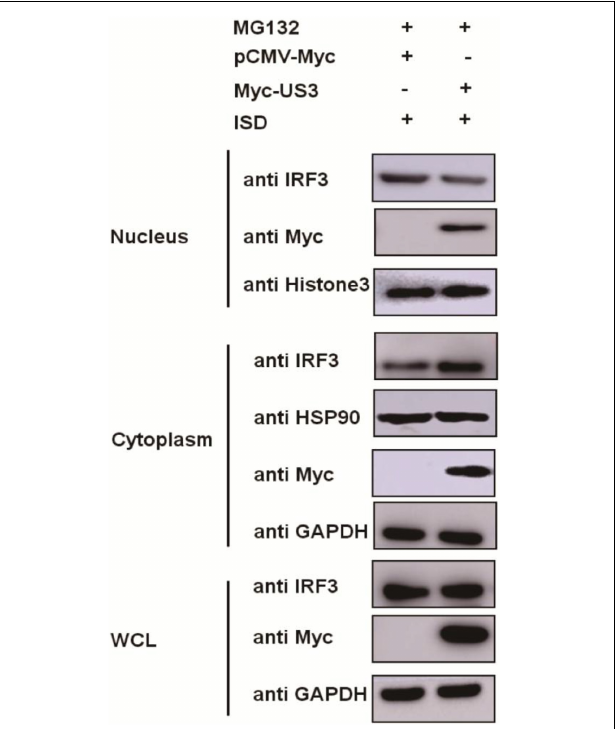
FIGURE 5 | ISD (2 µ g/mL) was transfected into PK15 cells in the presence of either pCMV-Myc (0.5 µ g) or Myc-US3 (0.5 µ g) for 24 h. Before collected, cells were treated with MG132 for 6 h. Then cytoplasmic and nuclear proteins were extracted and subjected to western blotting. Expression of IRF3 and Myc tagged US3 was detected with specific antibodies. HSP90 was used as a cytoplasmic protein marker, whereas Histone3 was used as a nuclear protein marker. GAPDH served as loading